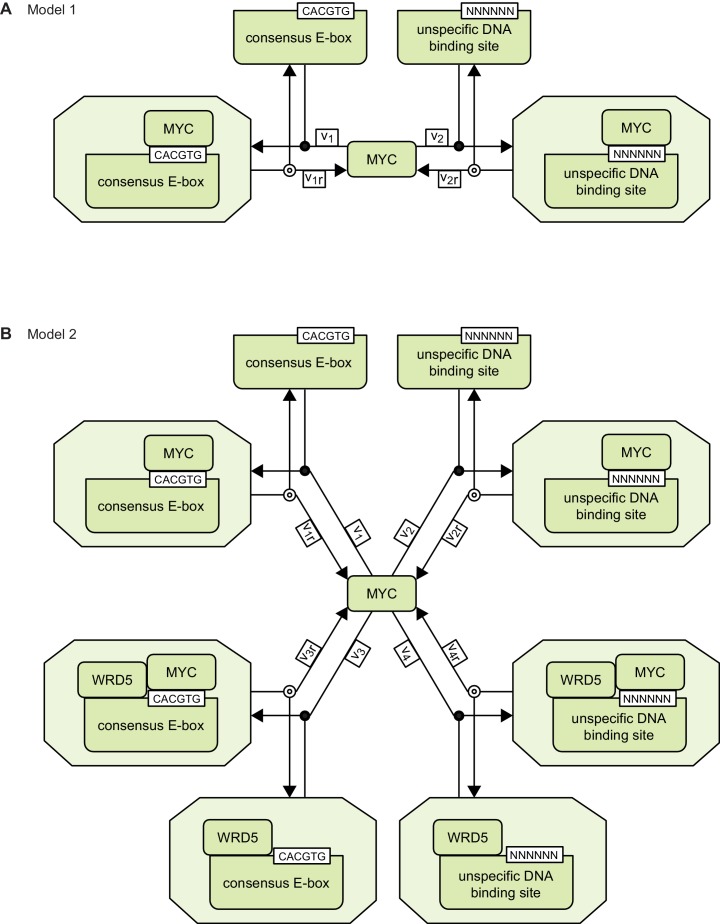
Schemes of models 1 and 2.